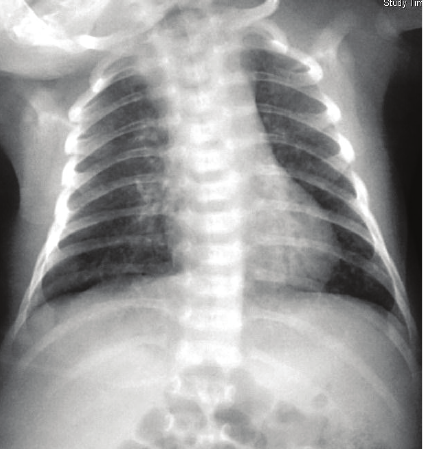
Figure 1: Diffuse patchiness on chest radiography in a neonate with Chlamydia trachomatis